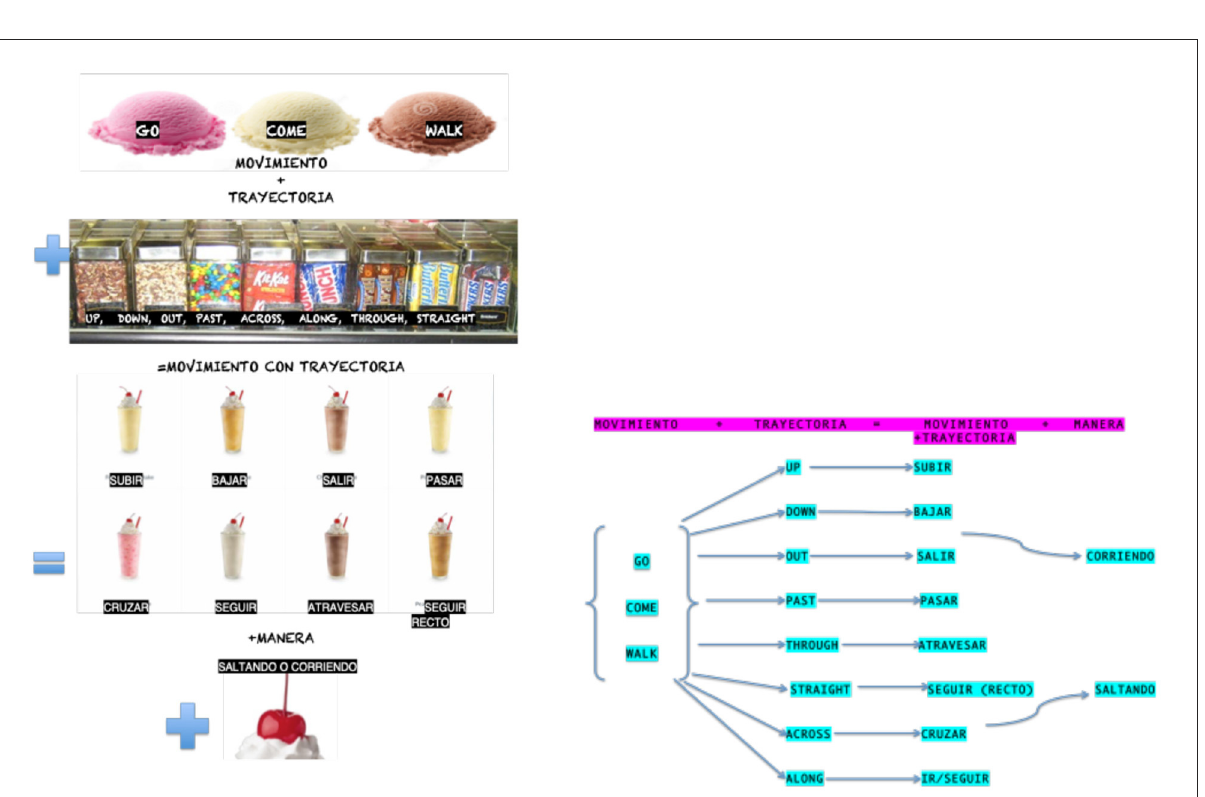
FIGURE3 Didactic models. Left, metaphorical, “Ice-cream”; Right, flowchart (Participant 1, Group